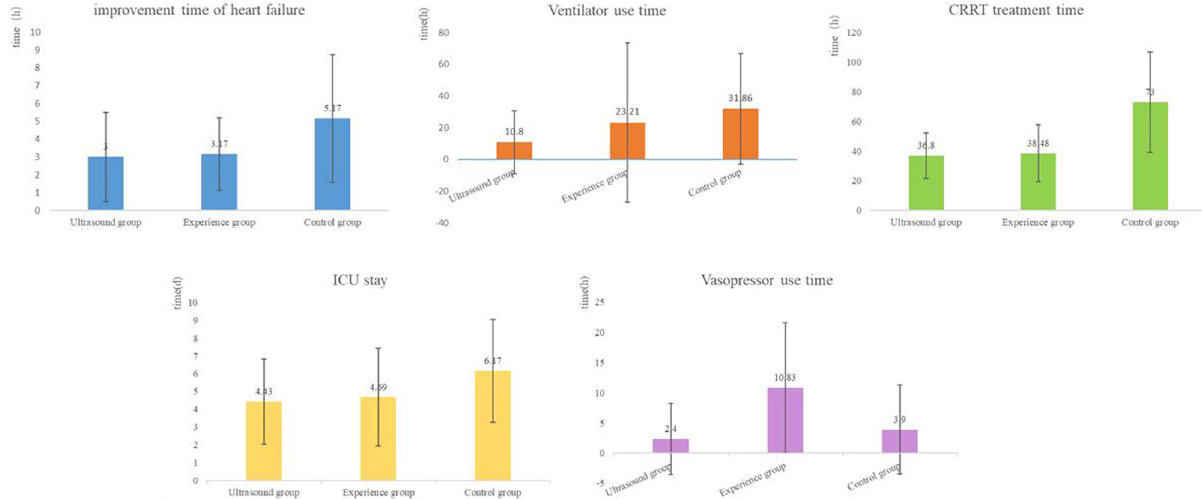
Figure 3. Comparison of observation indicators among three groups.